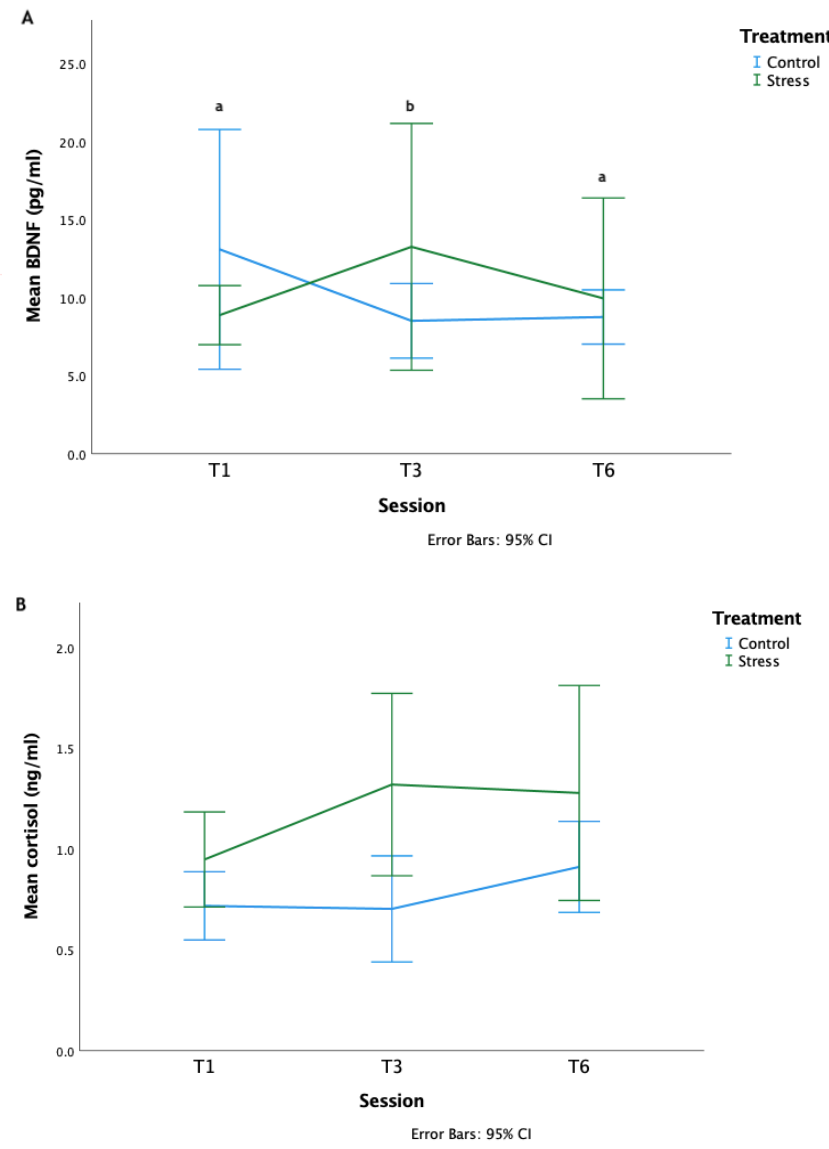
Figure 6. ( A ). Concentrations of BDNF (pg/mL) during the treatment. T = treatment session. Letters which differ, differ significantly at p < 0.01 between sessions. ( B ) Concentrations of salivary cortisol (ng/mL). T = treatment